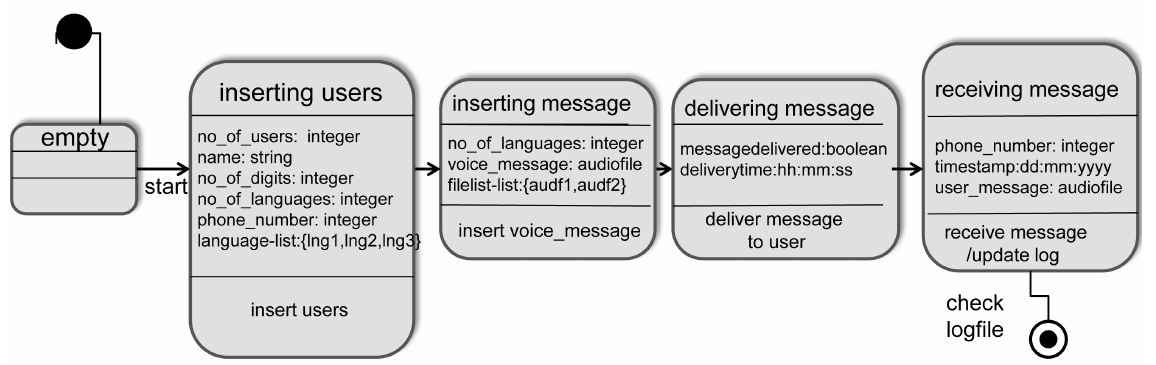
Figure 8. UML state diagram for